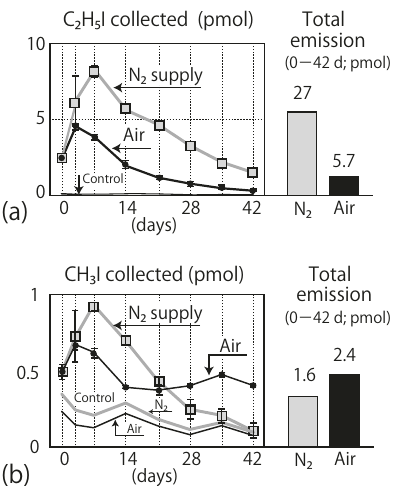
a Collected amount and total emission of C 2 H 5 I from the dark incubation bottle. b CH 3 I. Anoxic condition with N 2 supply and oxic condition with air supply are shown in gray square plots and black circle plots, respectively. VOIs were collected from the head-space of diatom incubation bottles in darkness and their total emissions over 42 days. These emissions were collected by fl ushing with either N 2 (anoxic conditions) or air (oxic conditions) as carrier gases. The plots and error bars are averages and ranges of incubation results of the two bottles ( n = 2), respectively. Many of error bars are behind the symbols. The incubation results are shown in Supplementary Tables S1 –